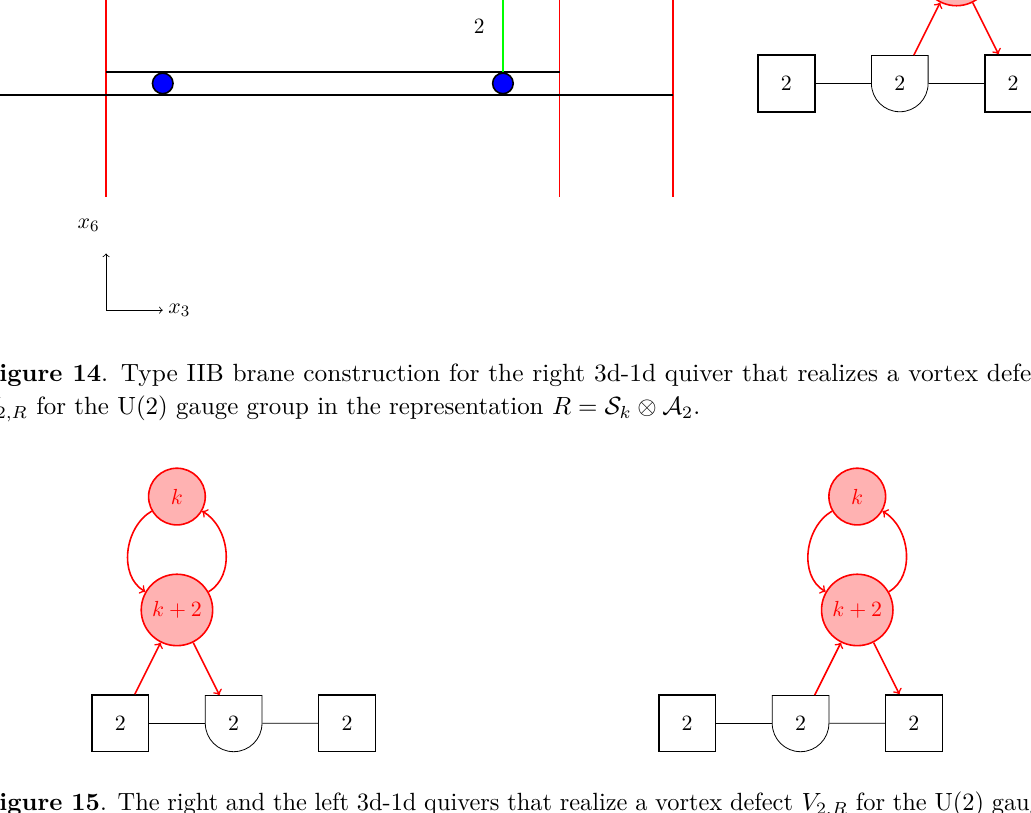
Figure 15 . The right and the left 3d-1d quivers that realize a vortex defect V 2 ,R for the U(2) gauge group in a representation R = S k ⊗ A 2